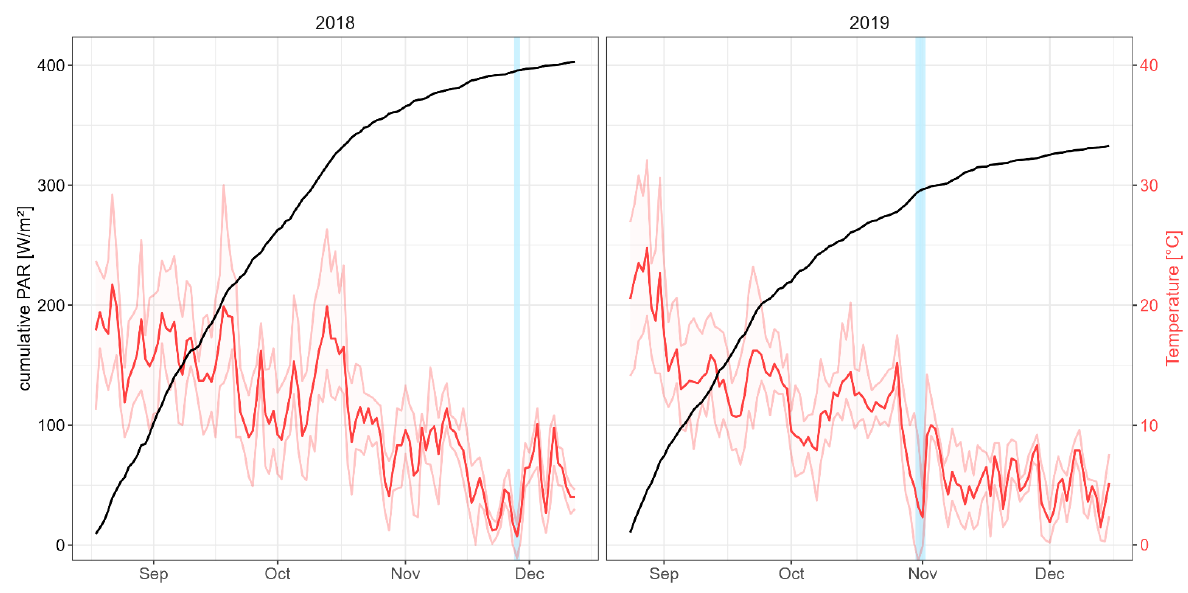
Figure 2. Cumulative photosynthetic active radiation (PAR) (W m −2 ) (black) and averaged temper- ature (°C) per day (red) during vegetation periods in 2018 and 2019. The light-red area presents the range according to minimal and maximal temperature (°C) per day. Frost events are illustrated by a blue vertical line (28 November 2018, 31 October 2019, 1 November 2019).